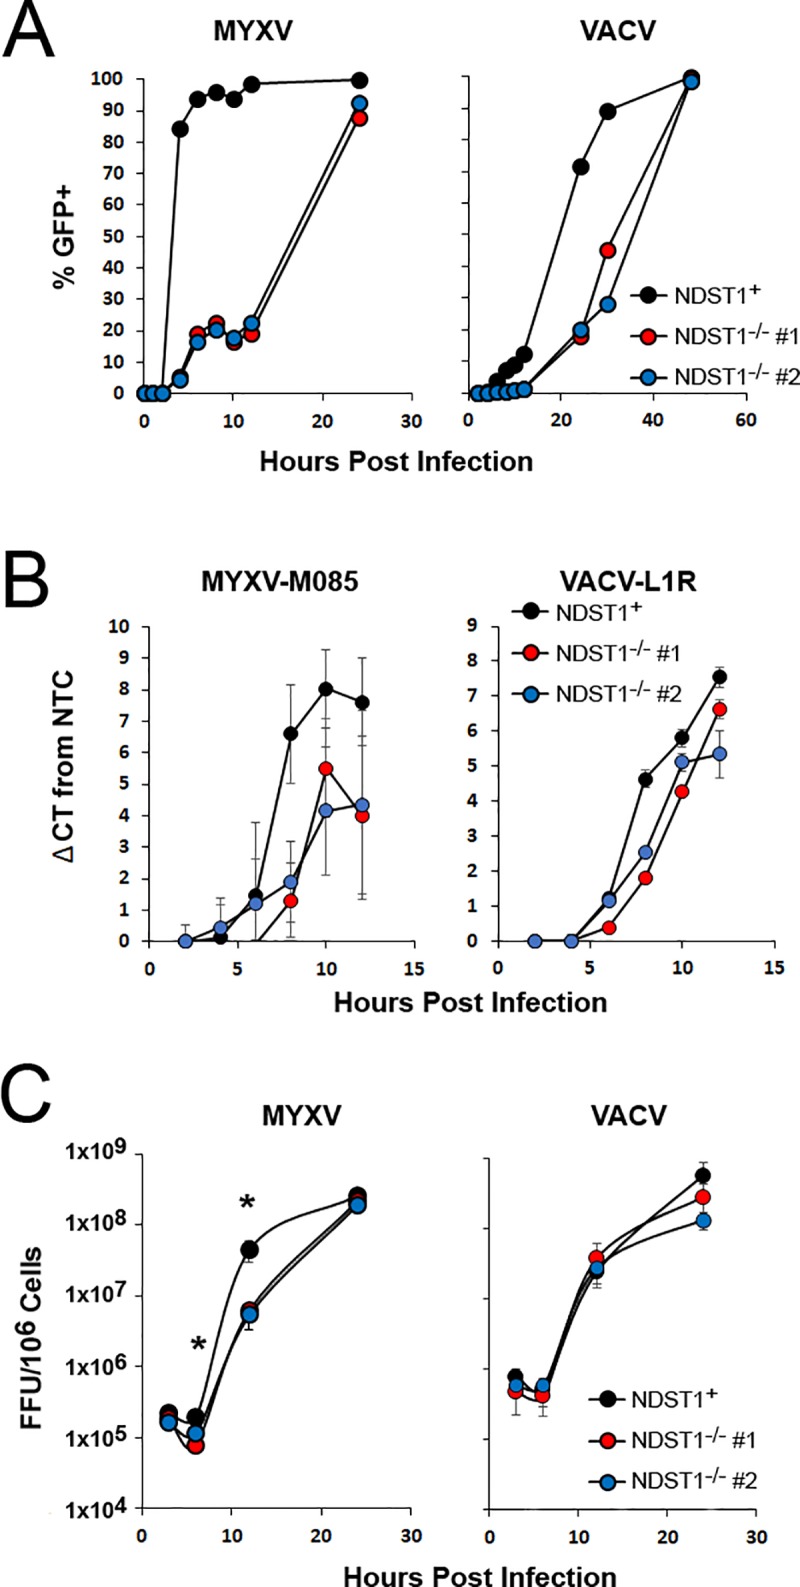
Loss of sulfation delays intracellular poxviral replication.(A) Kinetic analysis of GFP expression after initial infection of NDST1+ or deficient cells. NDST1+ or deficient B16/F10 cells were infected with either MYXV or VACV and GFP expression measured every two hours using flow cytometry. Data presented is representative of two independent experiments. (B) Abundance of MYXV or VACV genomes measured using qPCR. Data presented is representative of three independent experiments for both viruses each analyzed in triplicate and is presented as the change in cycle threshold value (ΔCT) from 2 hour baseline. (C) Production of new infection viral progeny in either NDST1+ or deficient cells measured using standard single step growth curve analysis. Data presented is a summation of two (VACV) or three (MYXV) independent experiments each conducted in triplicate. Statistical significance was determined using Students T-Test (* = p<0.05).